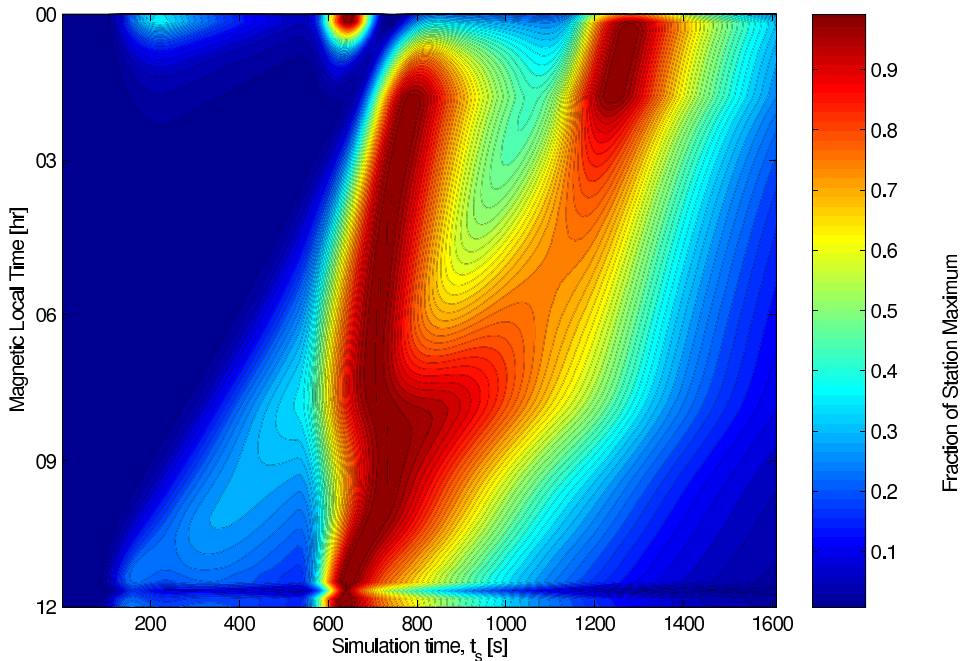
Fig. 6. Same as Fig.5, but normalized to the maximum response at each simulated station. Contours of (T i –T i 0 )/(T p –T i 0 ) are plotted as a function of MLT and simulation time, t s , where T i 0 is the value of T i at t s = 0 and T ip is the peak temperature seen at that station during the